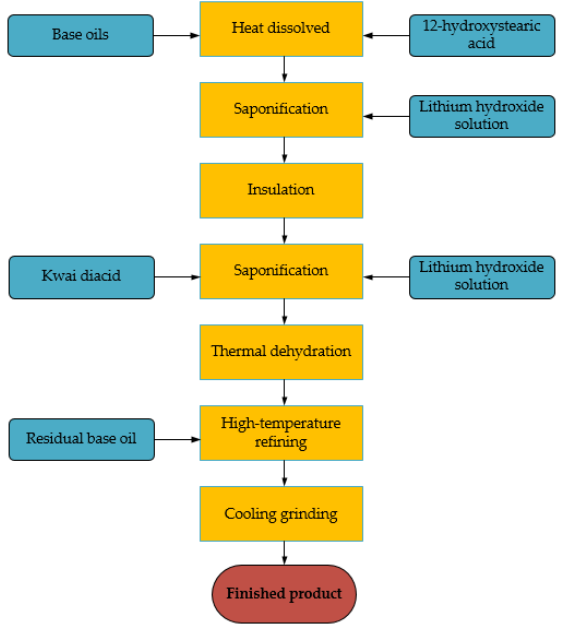
Figure 13. Flow chart of preparing wind turbine bearing grease (Adapted from [130]).